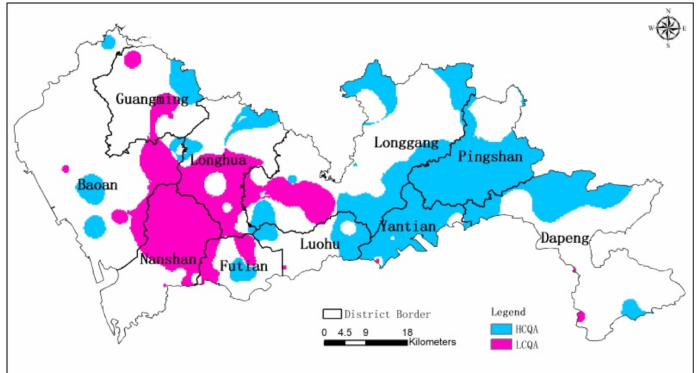
Figure 5. Spatial distribution of climate quality in Shenzhen.